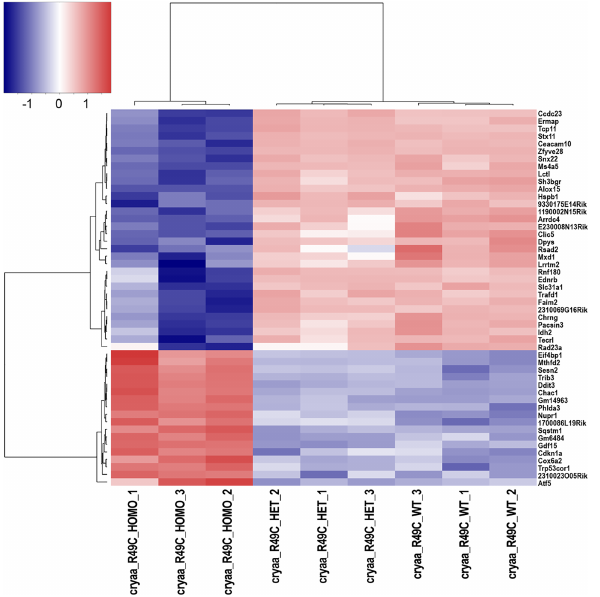
Fig 2. Heat map of genes with altered expression in Cryaa -R49C knock-in mutant lenses as displayed by the R package heatmap3 [31]. In order to illustrate relative log 2 fold-changes across samples, the values displayedper gene represent log 2 transformed counts-per-millionwith a prior count of 2, which were then rescaledto a mean of 0 with a standarddeviationof 1. The genesand samples were then re-organized by hierarchical clustering to illustrate the similarity of expressionchangeswithin and across